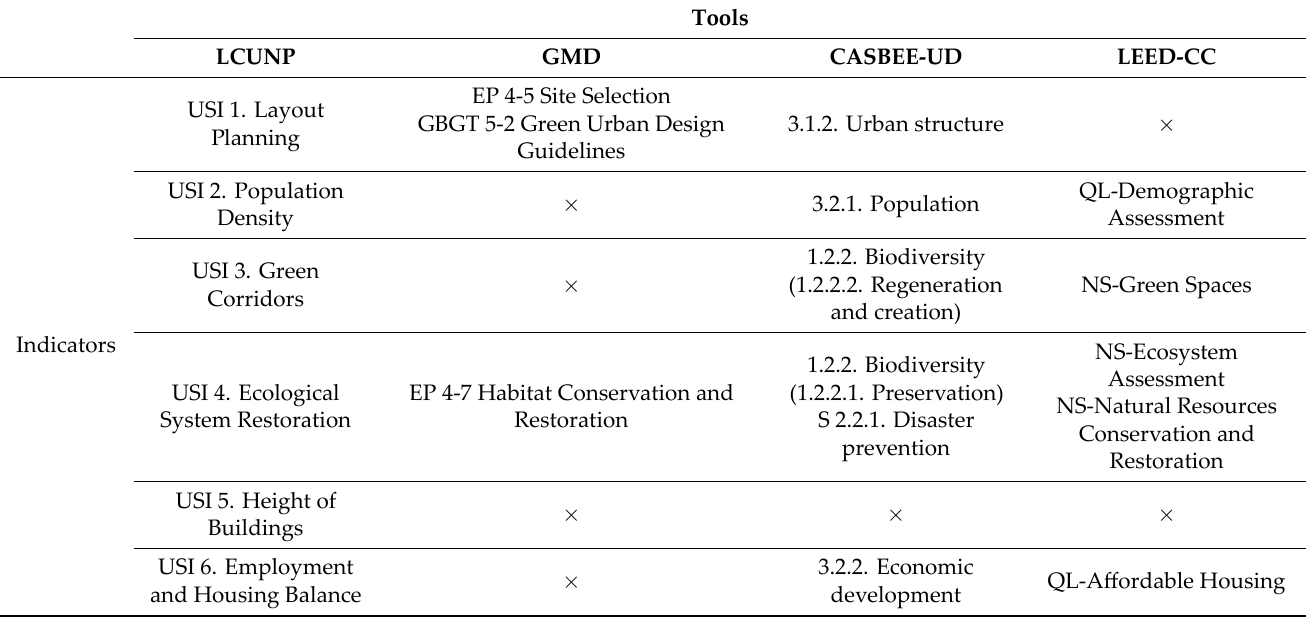
Table 14. Benchmarking and indicators